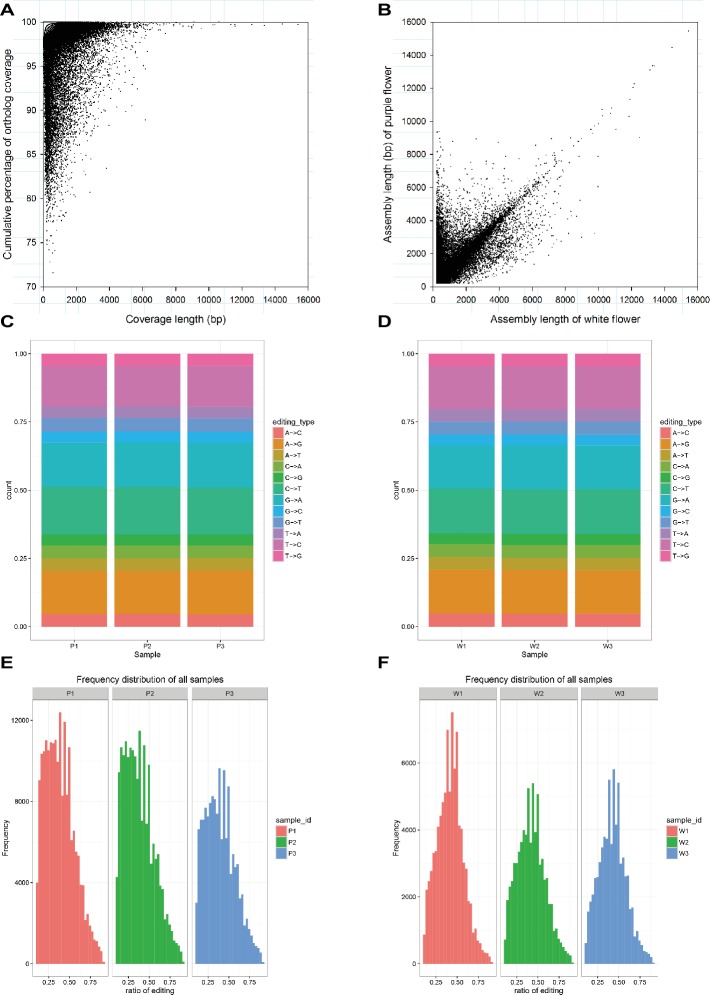
Characteristics of the transcriptome assembly in M. malabathricum. Coverage and assembly length in orthologous unigenes (A,B). Each dot represents a pair of orthologs. Distribution of the different SNP types in the purple (C) and white (D) varieties. Frequency of the different ratio of RNA editing in the purple (E) and white (F) varieties.